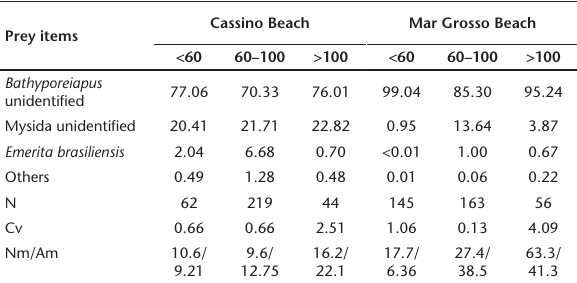
Table 3. Variations in Index of Relative Importance of the main items ingested by the juvenile flatfish of the Cassino and Mar Grosso beaches, along the ontogeny. Non-empty stomachs (N), Coefficient of Vacuity (Cv), mean number and area (mm 3 ) of preys (Nm/Am). Do not have any individual collected in